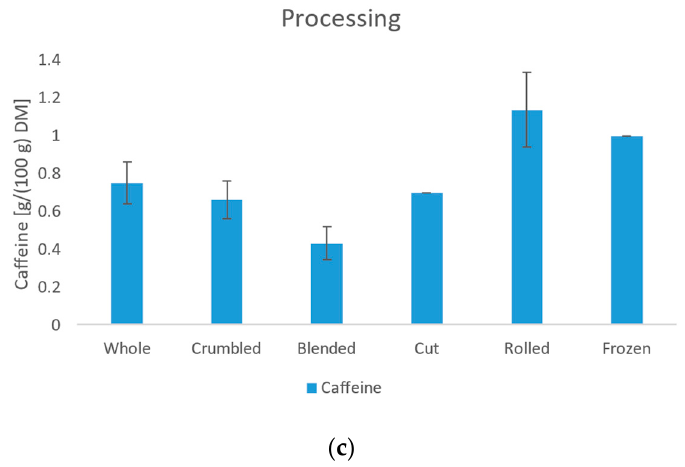
Figure 5. Influence of the leaf type ( a ), the variety ( b ), and the processing method ( c ) on the caffeine content.